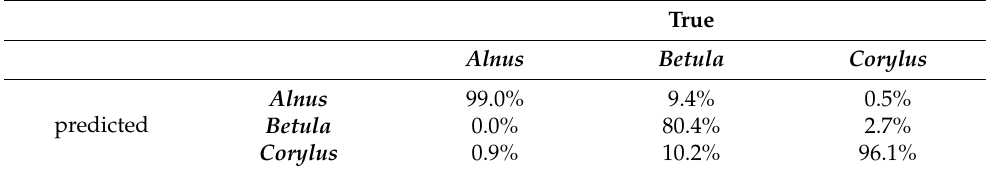
Table 3. Confusion matrix of predictions for the testMix dataset averaged for all investigated models.